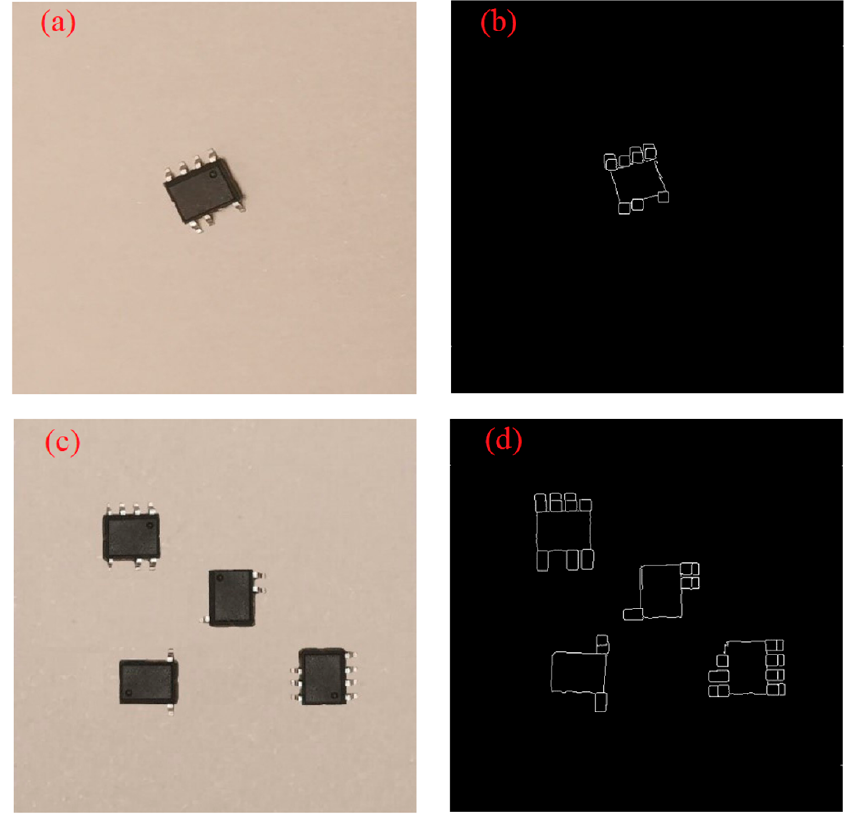
Figure 5. Chip data set. ( a ) One chip before enhancement. ( b ) One chip after enhancement. ( c ) Multiple chips before enhancement. ( d ) Multiple chips after enhancement.